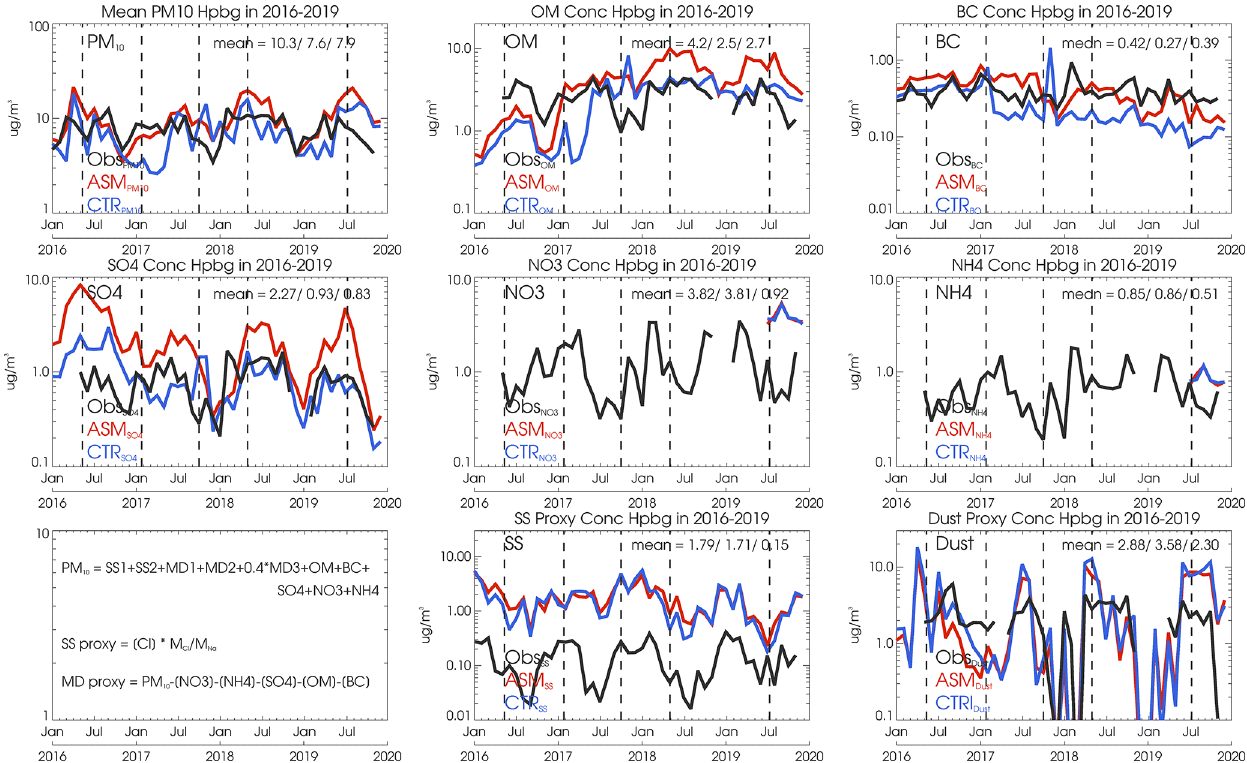
Figure 7. Comparison of mass concentrations averaged over IFS levels L54–L60/L127–L137 for L60/L137 model versions and measured by ACSM and filter probes at the Hohenpeißenberg GAW station for 2016–2019. From the top left to the bottom right: PM 10 , OM, BC, SO 4 , NO 3 and NH 4 , chlorine, sea-salt and dust proxies as described in the text. Vertical black lines indicate major model updates as in Table 1. Note the different y